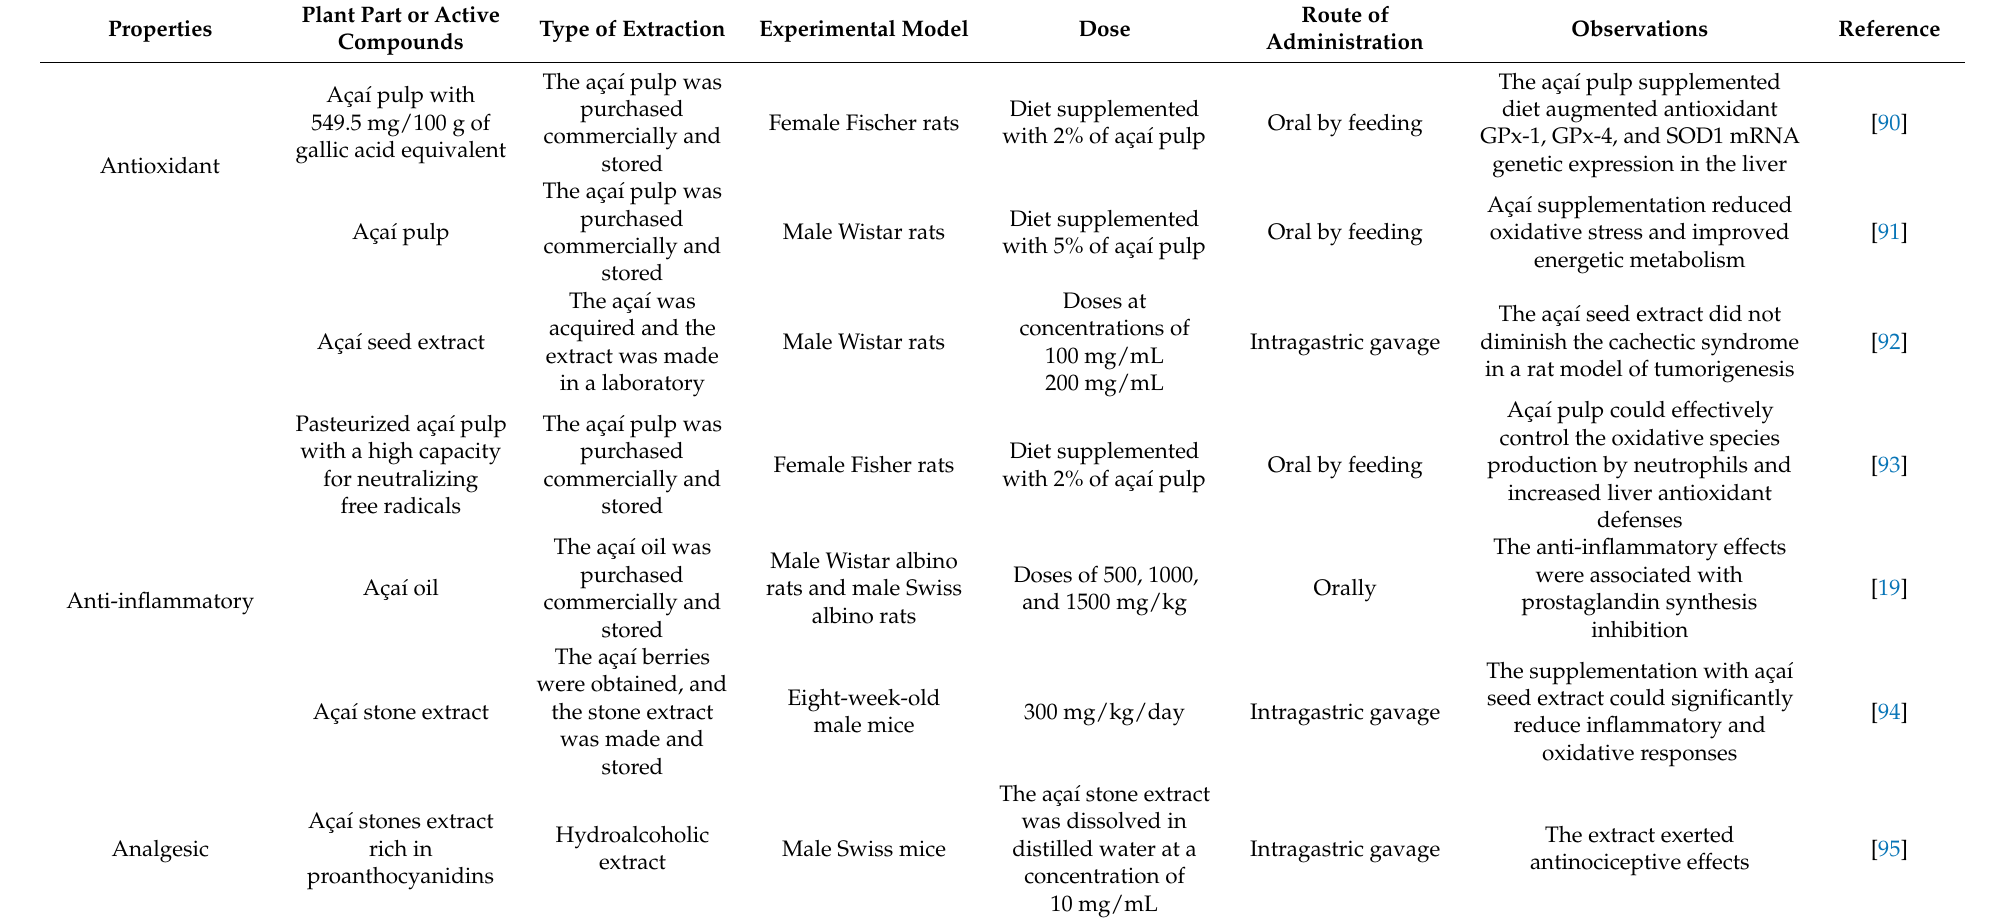
Table 2. In vivo biological and pharmacological activities of various extracts and pure compounds of aça í